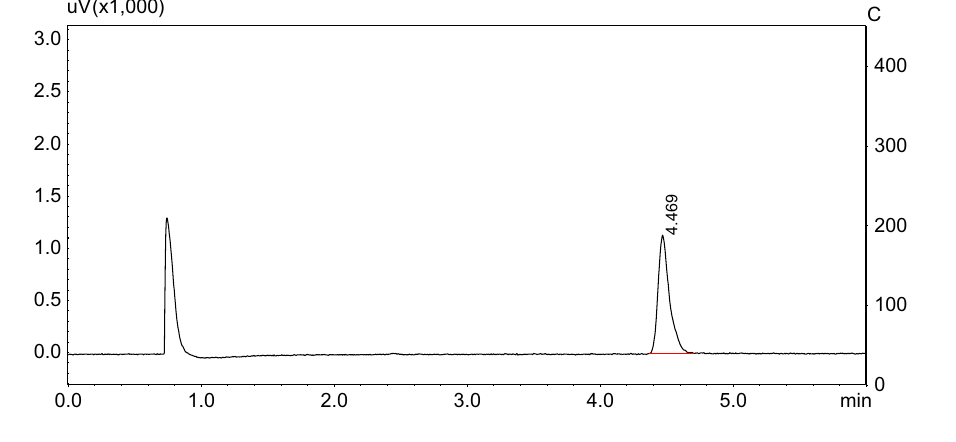
Figure 1. Chromatogram of chlorpyrifos.